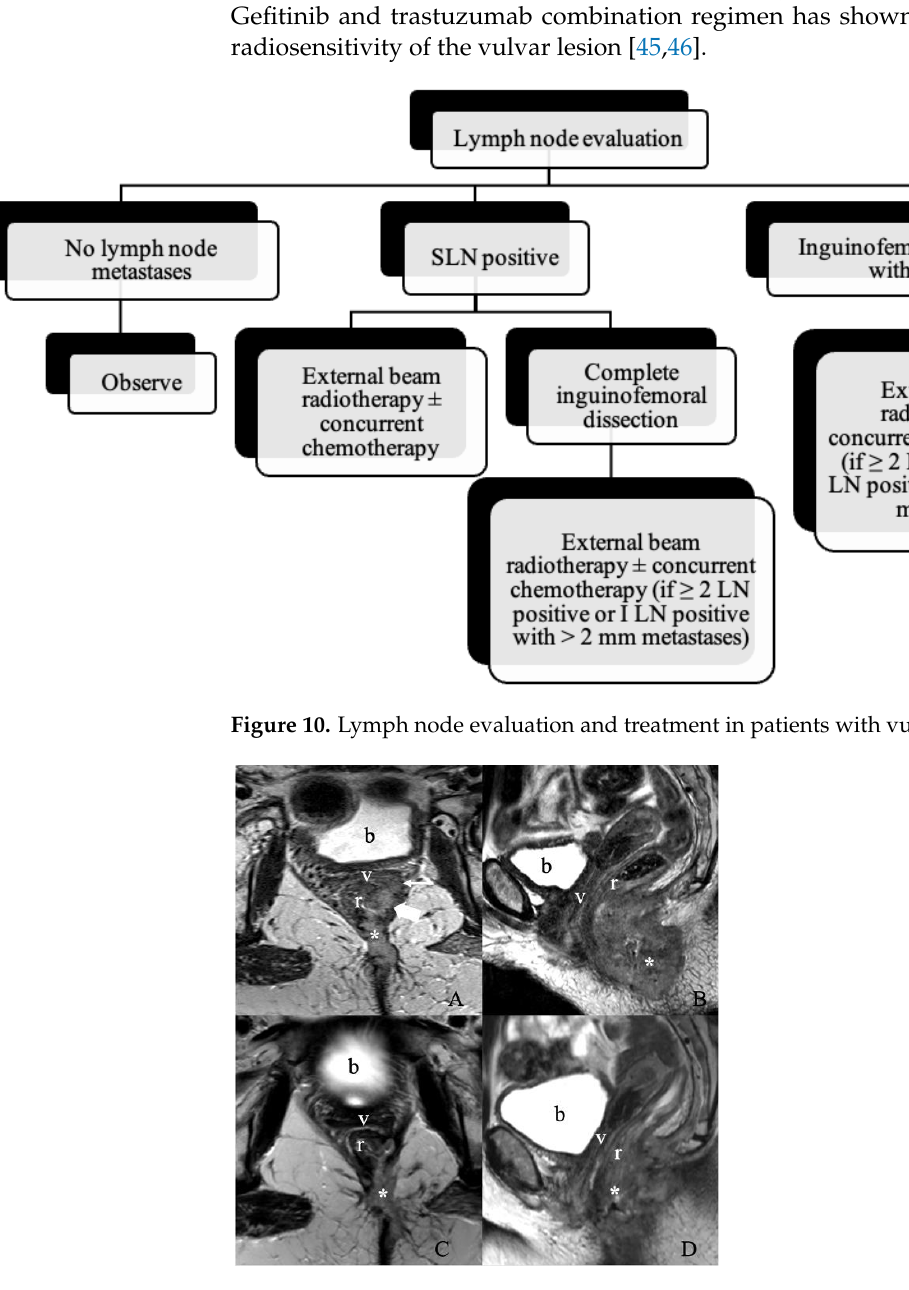
Figure 11. Treatment response assessment. A 55-year-old female with recurrent vulvar squamous cell carcinoma. ( A ) Axial and ( B ) sagittal T2 weighted MRI images show a large vulvar mass (asterisk) invading both the low rectum (thick arrow) and diffusely throughout the left semi circumferential anal canal (not shown), with additional invasion along the left posterolateral aspect of the upper two-thirds of the vagina (thin arrow). No evidence of enlarged lymph nodes. The findings correspond to FIGO stage IIIA. A Follow-up MRI after three months of chemoradiation was obtained. ( C ) Axial and ( D ) sagittal T2 weighted image MRI show an interval decrease in the size of the treated left vulvar mass invading the lower rectum, anal canal, left upper one-third of the vagina, and left lateral pelvic sidewall. (b, bladder; v, vagina; r,